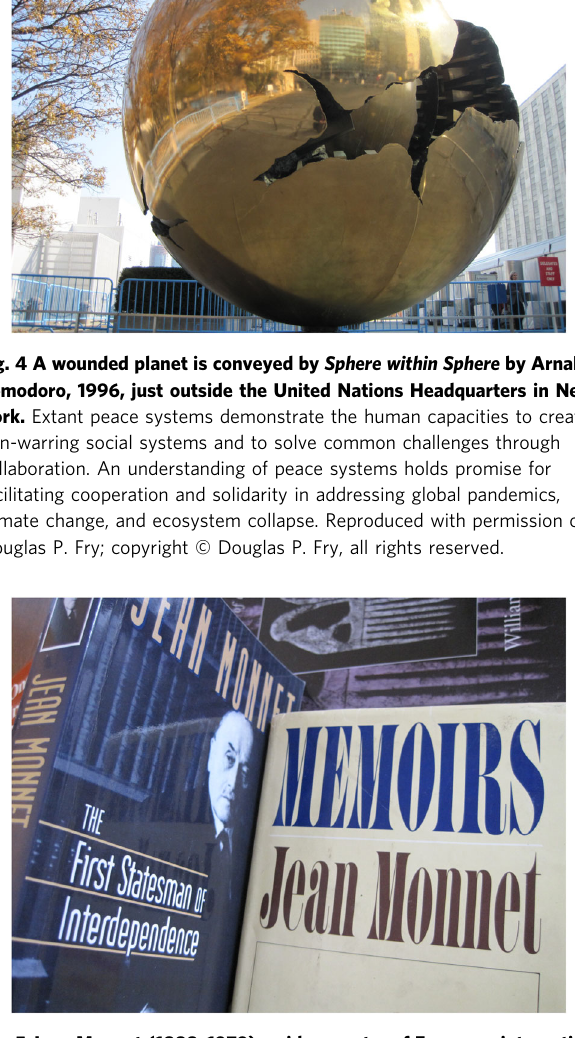
Fig. 5 Jean Monnet (1888 – 1979), avid promoter of European integration, epitomises the type of visionary peace leadership sometimes seen in peace systems that can unify hostile neighbours and guide them on a new path away from the scourge of war. Reproduced with permission of Douglas P. Fry; copyright © Douglas P. Fry, all rights